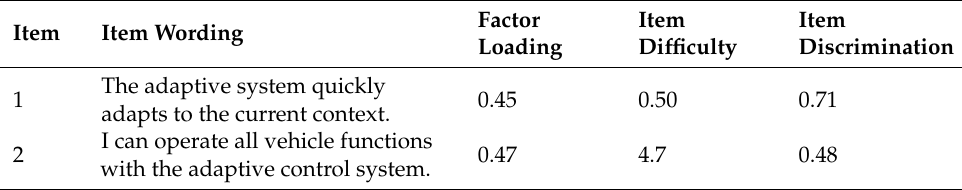
Table A2. Items of Factor 2 “Intelligence and